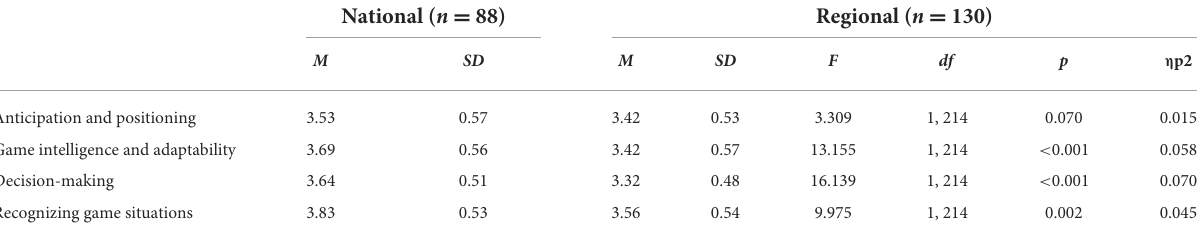
TABLE 5 Descriptive statistics of national and regional players for each subscale of the TSQT ( n =